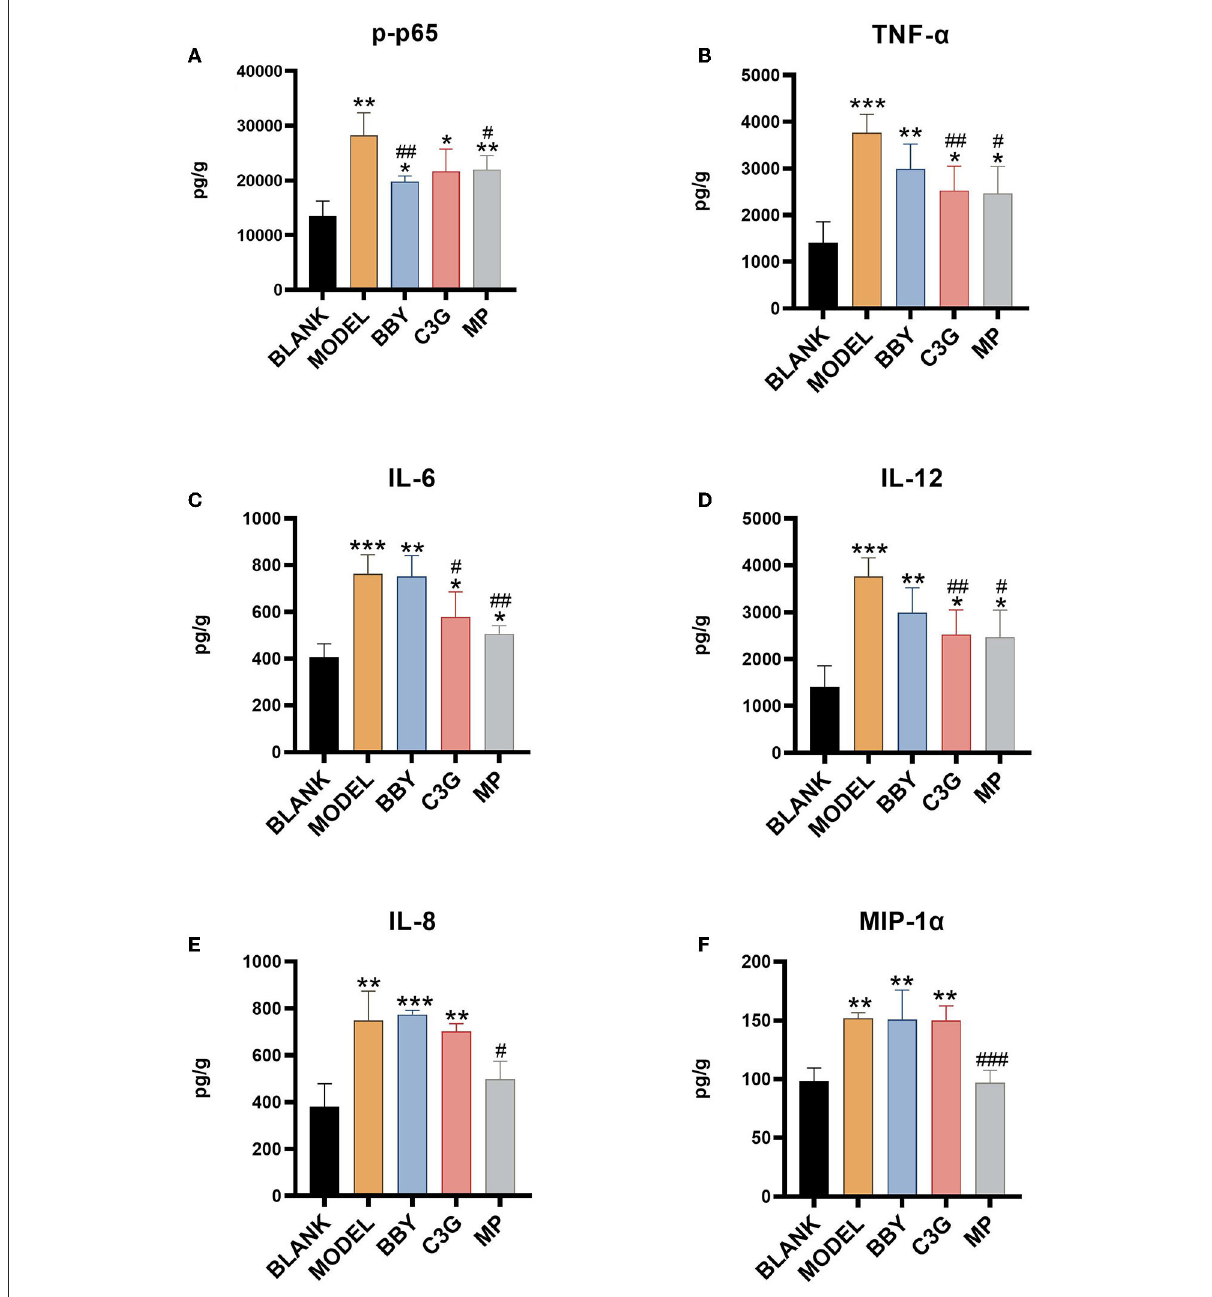
FIGURE7 (A) p65 phosphorylation level, (B) TNF- α level, (C) IL-6 level, (D) IL-12 level, (E) IL-8 level, (F) MIP-1 α level. *Indicated a significant difference compared with the BLANK group, # indicated a significant difference with the MODEL group, where * p < 0.05, ** p < 0.01, *** p < 0.001; # p